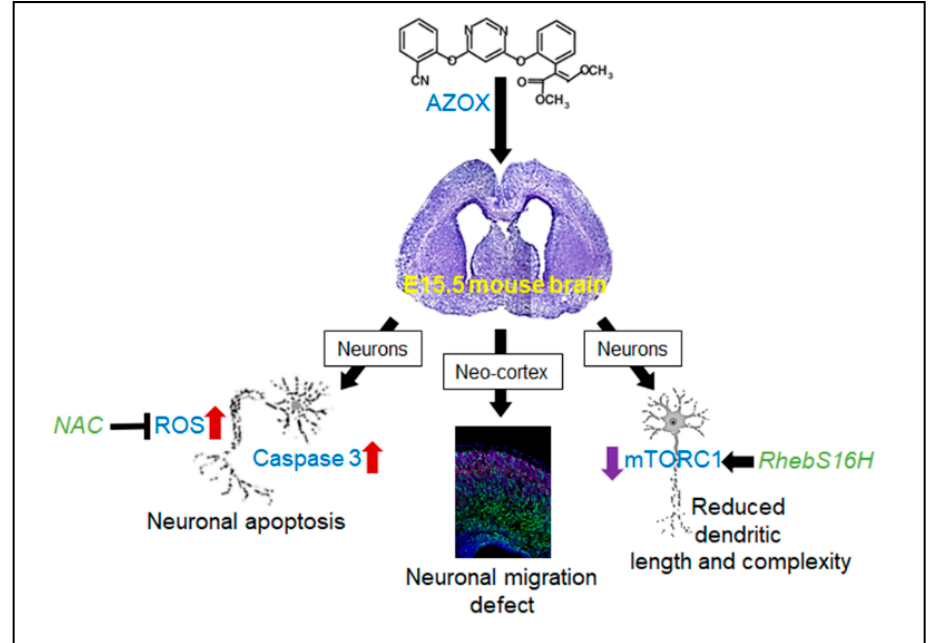
Figure 6. AZOX produced neurotoxicity and reduced neurite formation, and that was dependent on mTORC1 activity. Induced mTORC1 activity prevented AZOX effect on neurite formation; ROS was accumulated in neurons and caused viability reduction, NAC treatment reduced ROS mediated cell death and apoptosis in primary neurons. The axonal and dendritic branching was reduced in AZOX treated neurons, which was improved by the forced activation of mTORC1 by RhebS16H. Lastly, AZOX has inhibited neuronal migration in the neo-cortex.